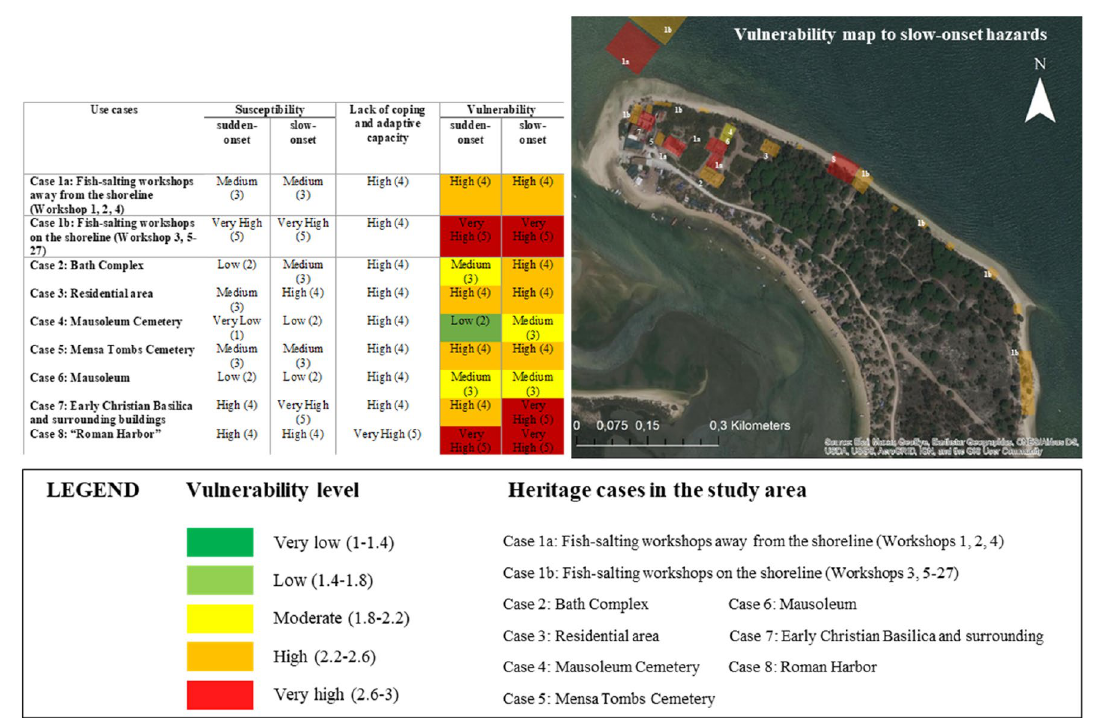
Fig. 5 Vulnerability assessment and maps for the two categories of sudden- and slow-onset